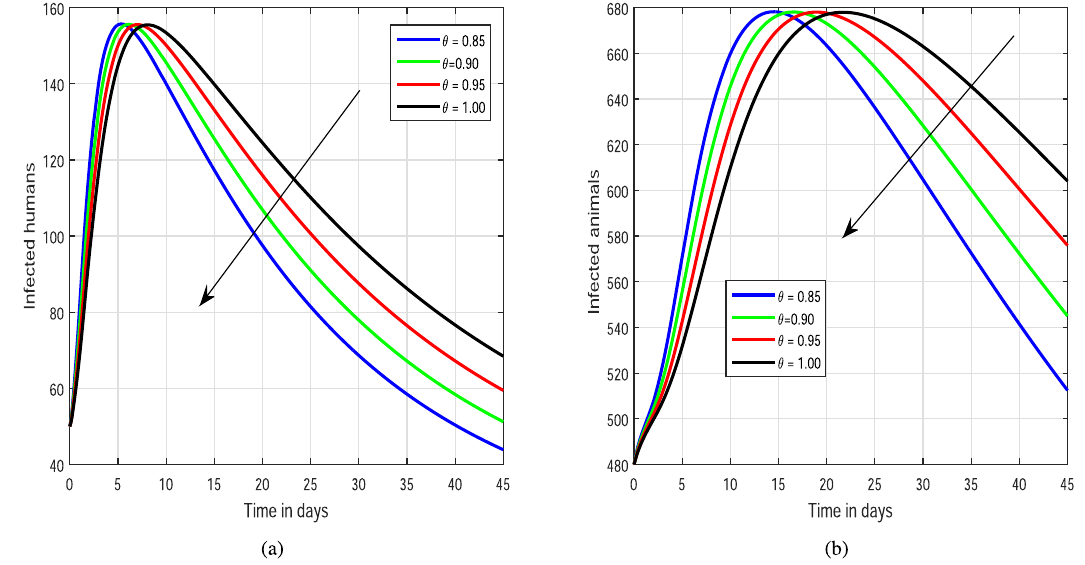
Figure 1: Numerical results showing the dynamical behaviour of infected individuals of the suggested model ( 9 ) of zoonotic infection with variation of θ , i.e. = θ 0.85, 0.90, 0.95 , and